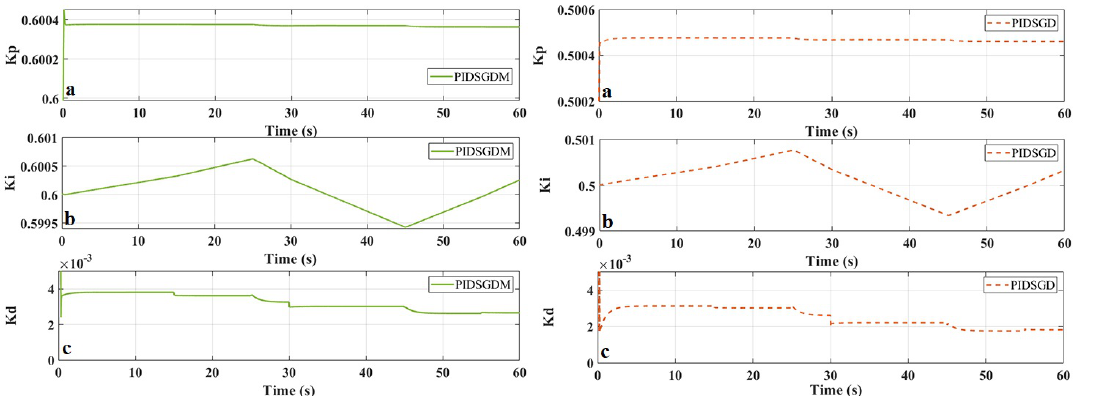
Figure 16. ( a ) Adaptive gain K p ; ( b ) adaptive gain K i ; ( c ) adaptive gain K d